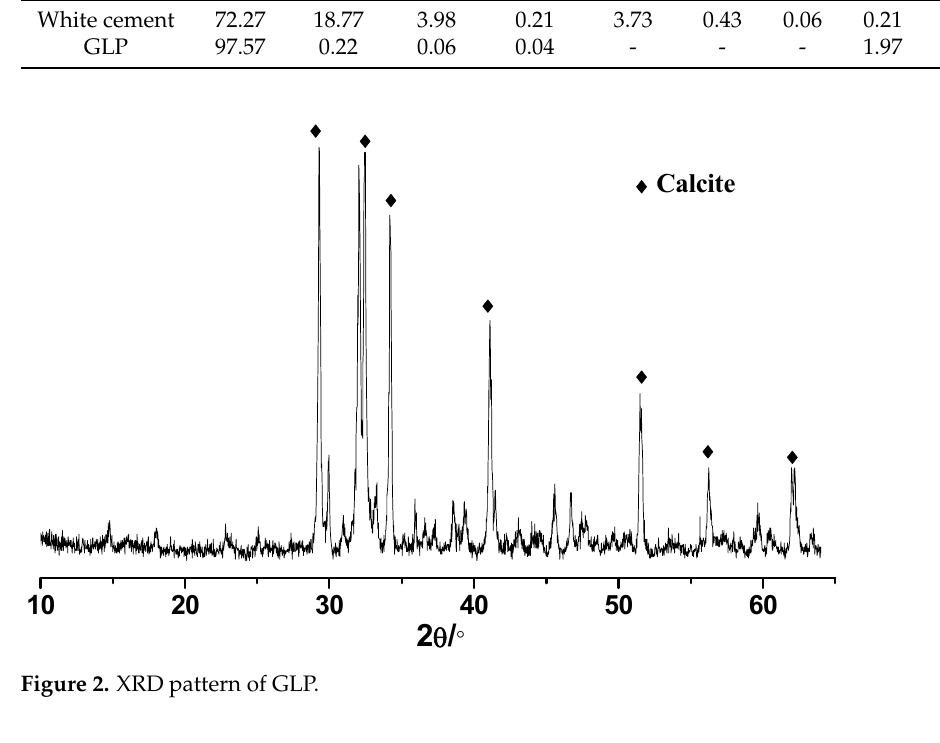
Figure 3. The particle size distributions of cement and GLP. River sand with a fineness modulus of 2.5 and a density of 2.62 g/cm 3 was used as the fine aggregate. Crushed gneiss with a diameter between 5 mm and 25 mm was used as the coarse aggregate. 2.2. Mix Proportions and Sample Preparation Different model types exist in the RSM analysis package, including Box–Behnken, Cen ‐ tral Composite, historical, and so on. In Box–Behnken design, factors are usually taken at three levels and all the design points fall within the safe operating zone. It is considered to be more proficient and powerful than other designs. In addition, it is typical for three input variables, which is the case in the current study. Thus, it is used for experimental design and data analysis. The independent variables used are w/b, vs., and C g , represented by factors